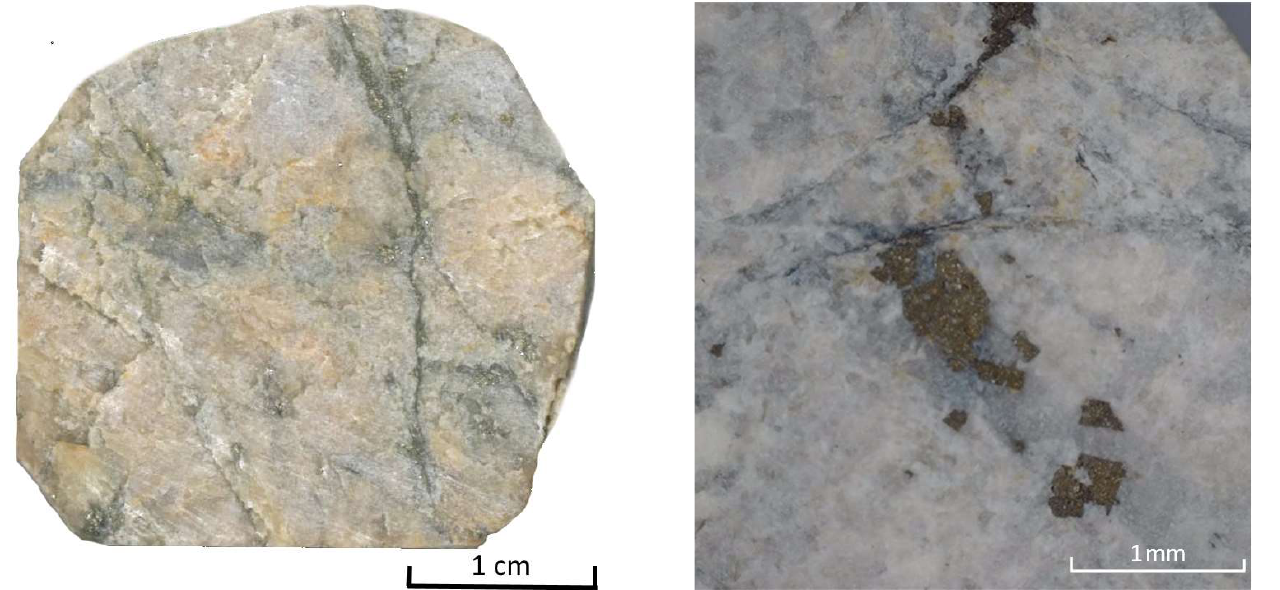
Figure 2. Bamskoe deposit’s ore samples.